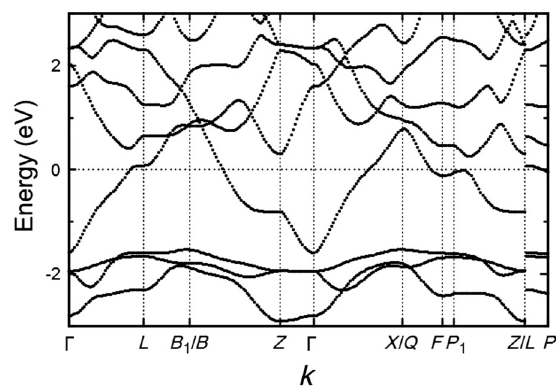
FIG. 10. Calculated band structure of Ba 2 N.